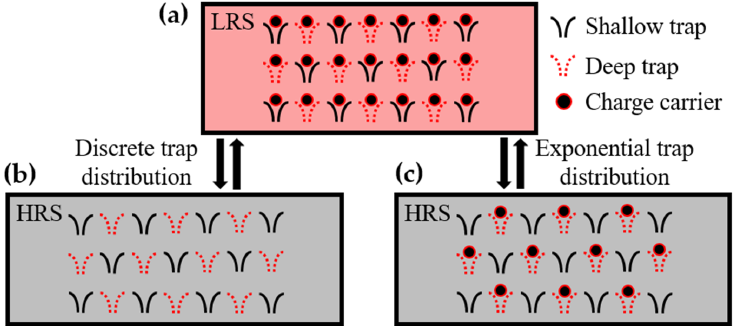
Figure 4. Schematic illustration explaining the physical mechanism of endurance degradation in Al/ α TiO x /Al interfacial RRAM device. ( a ) LRS after the SET process, in which all traps are filled by the charge carriers. ( b ) HRS after the RESET process, in which all traps are emptied when assuming the discrete trap distribution. ( c ) HRS after the RESET process when assuming the exponential trap distribution. Certain traps do not release the charge carriers during the RESET process.